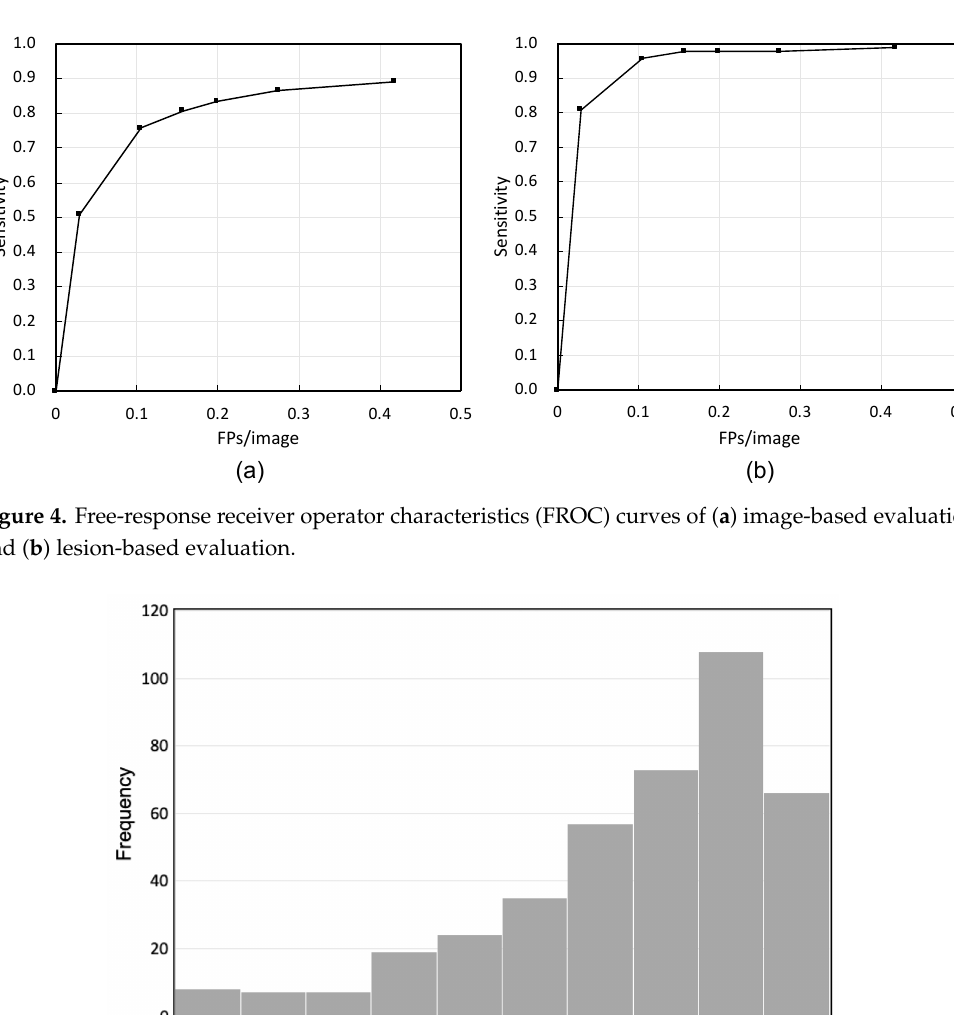
Figure 3. Detection results. ( a–c ) Successful gastric cancer detection, ( d ) false positives (FP) in healthy subjects, and ( e ) false negative in the abnormal case.